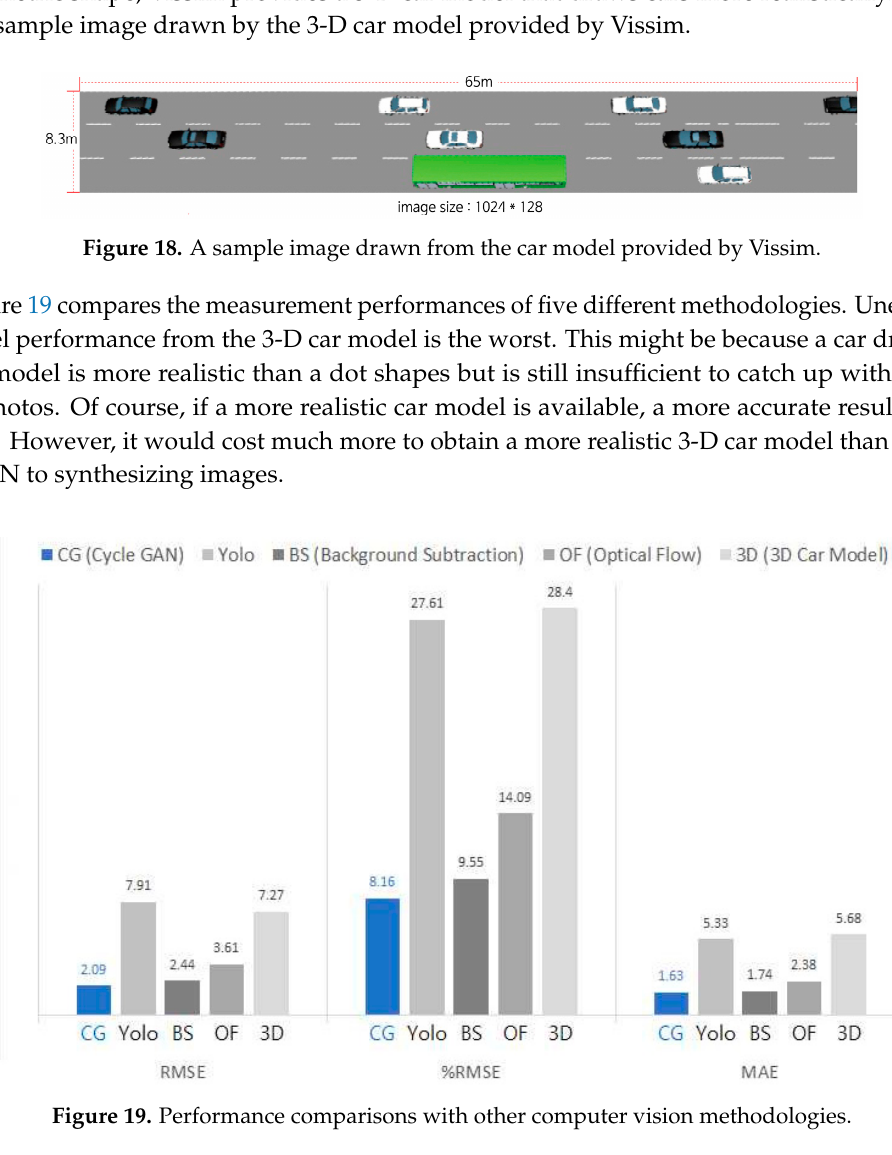
Figure 17. A sample image with motion vectors from an optical flow methodology.